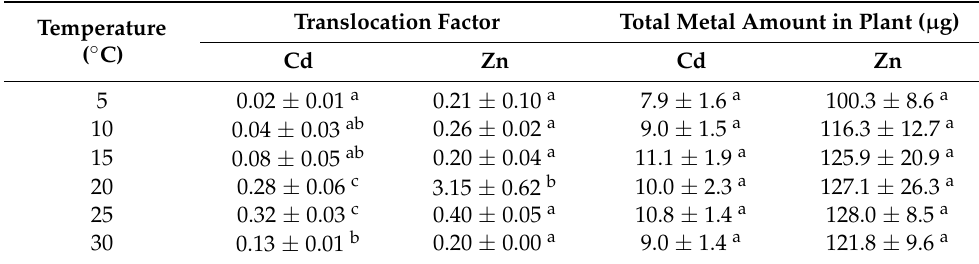
Table 1. Translocation factor and total metal amount in plants. The same letters indicate no significant differences between samples according to the Tukey–Kramer test ( p < 0.05).